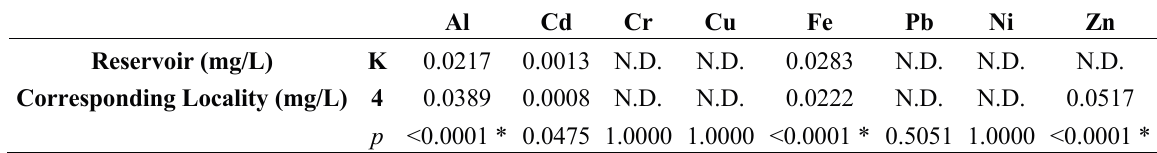
Table A7. Statistical variation between Reservoir K and its feeding Locality 4.